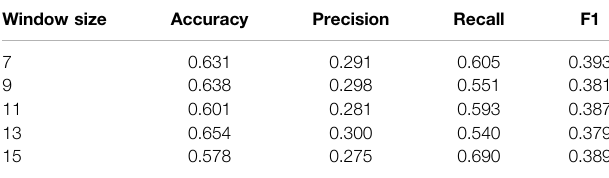
TABLE 3 | Effect of the sliding window on the model. Window size